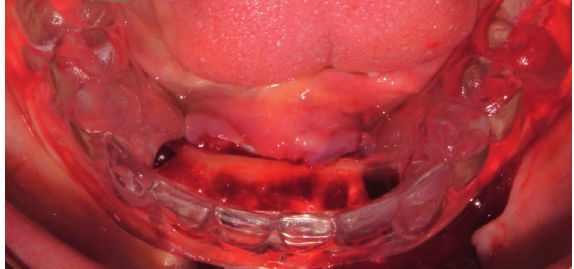
Figure 5: Adaptation of the surgical guide prior to the placement of dental implants.